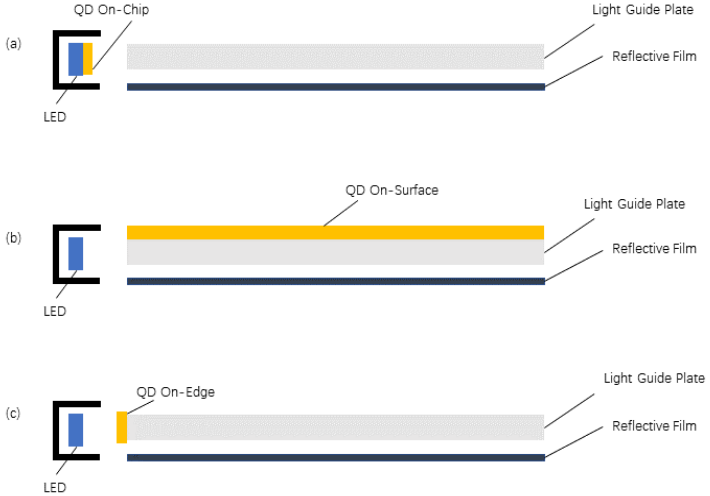
Figure 12. Schematic of quantum dots backlight: ( a ) “On-Chip” structure, ( b ) “On-Surface” structure ( c ) “On-Edge”